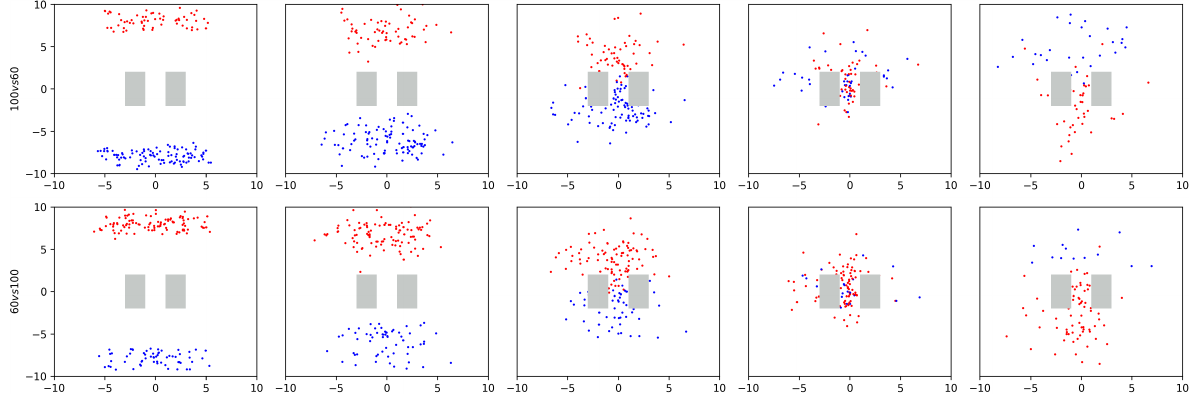
Figure A2. Vertical view of the asymmetric case about large-scale UAV attack and defense behaviors under ν = 0.08, e r =